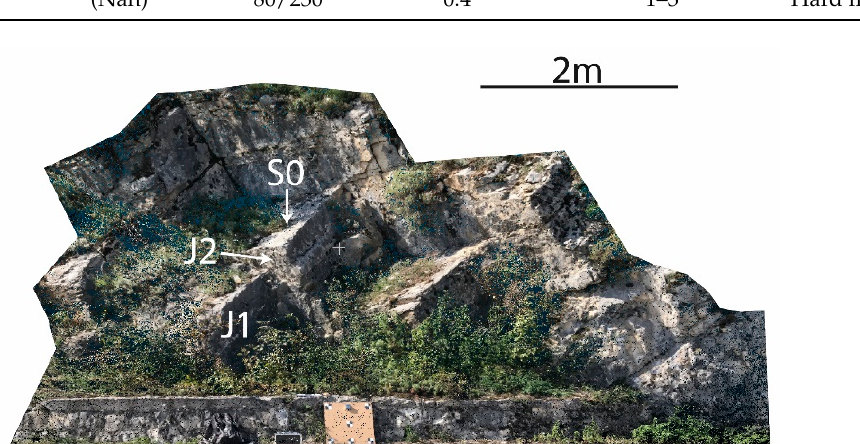
Figure 7. A terrestrial photogrammetric 3D model of a roadside section of the analysed slope. Table 6. Site-dependent discontinuity properties (site 1/site 2/site 3/site 4), including UCS, surface weathering condition, surface shape and